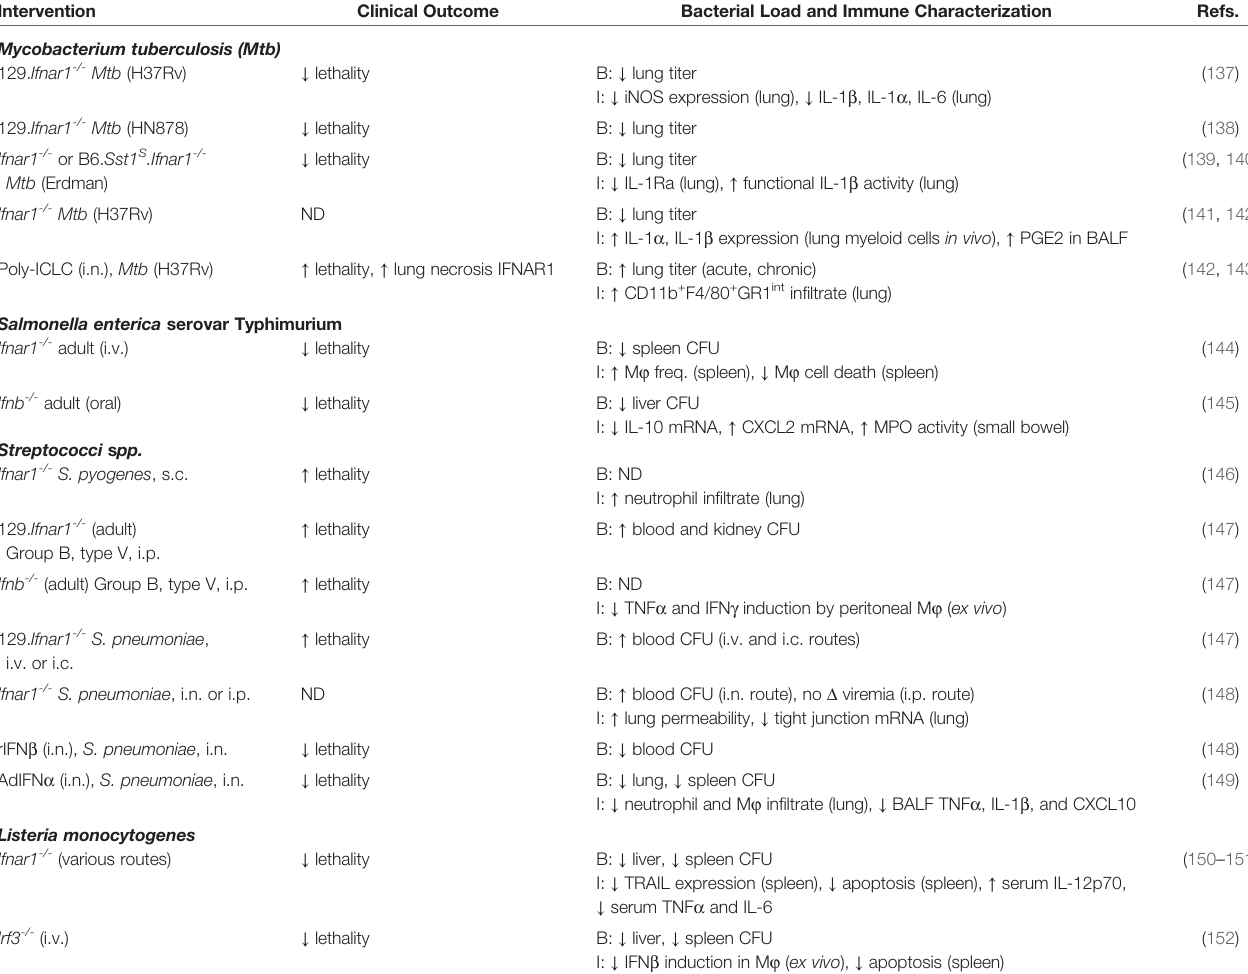
TABLE 2 | Summary of IFN a and IFN b functions in mouse models of bacterial infections. Intervention Clinical Outcome Bacterial Load and Immune Characterization